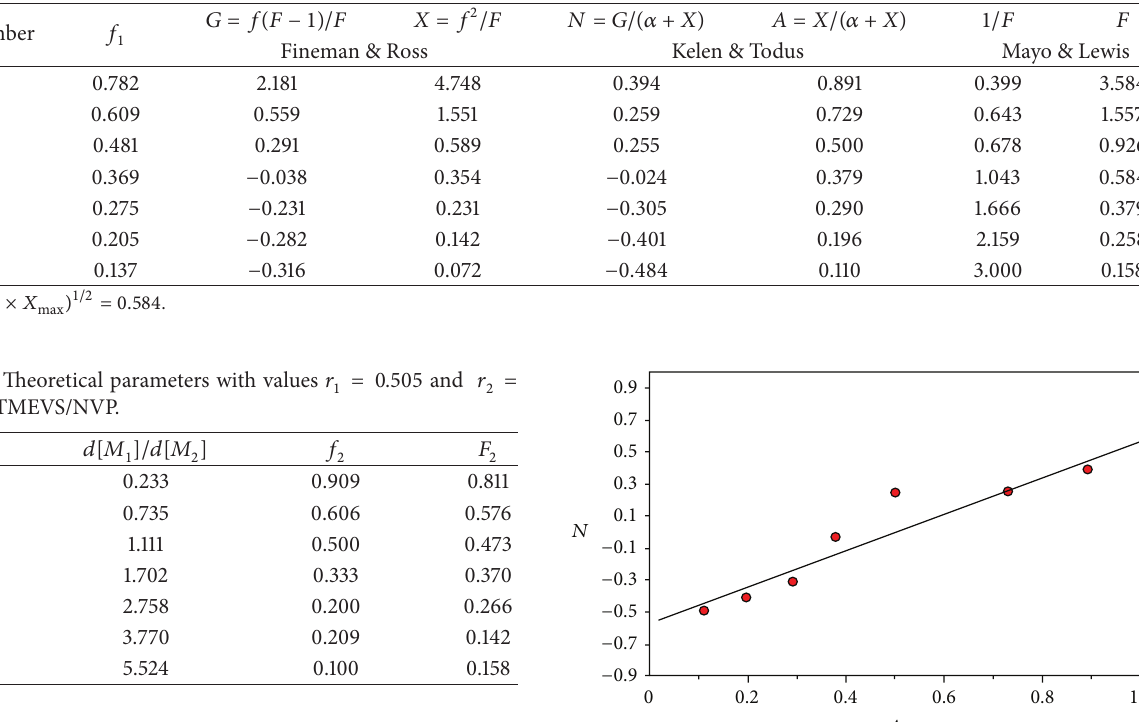
Table 2: Fineman-Ross, Kelen-Tudos, and Mayo-Lewis parameters of TMEVS/NVP.